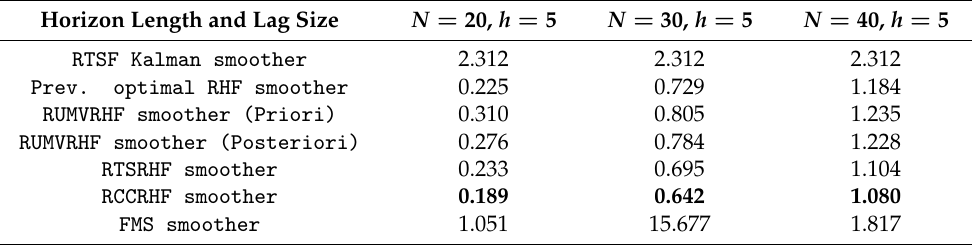
Table 3. RMSE errors for the time interval [ 201 350 ]